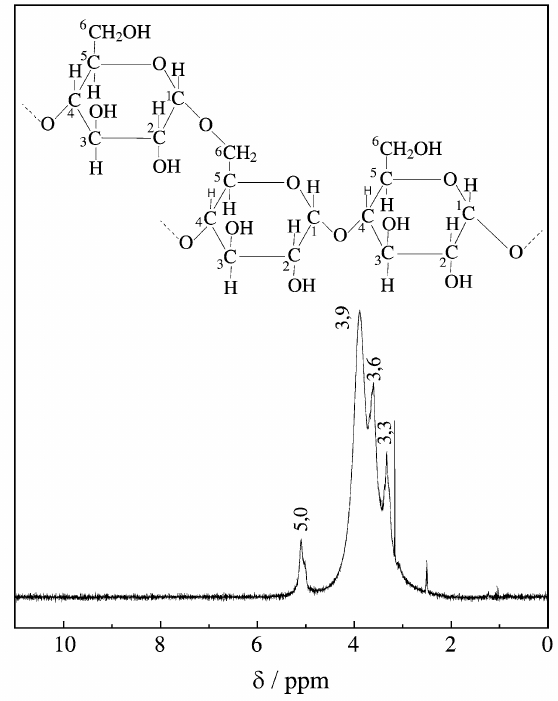
Figure 2. 1 H-NMR spectrum of the amylopectin-rich starch.